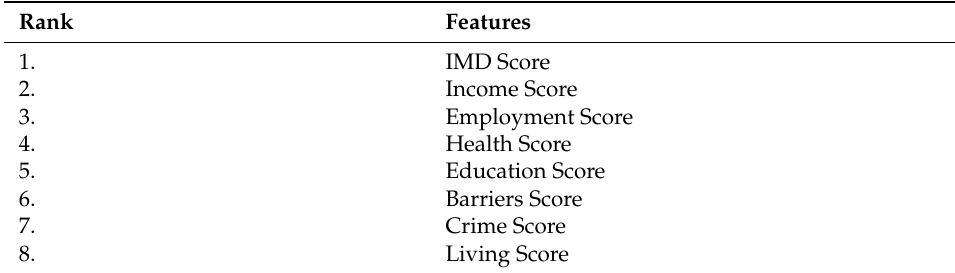
Table 1. List of the features of the wards in the Greater London